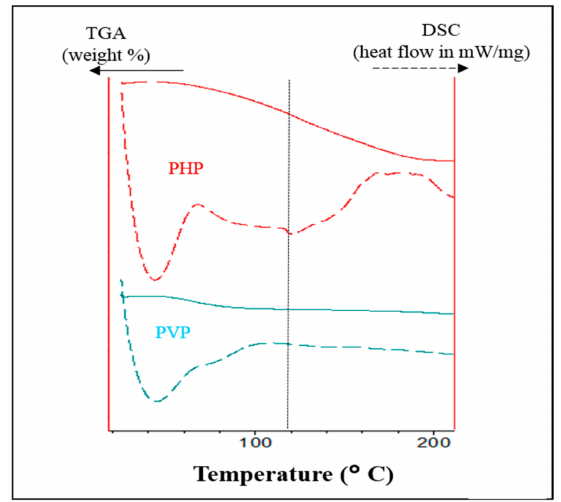
Figure 4. Overlay of thermograms for simultaneous DSC-TGA. The solid lines represent the TGA curve (unit at left Y-axis) and dotted lines with DSC curve (unit at right Y-axis); the curves for PHP marked in the red color line and for PVP in blue